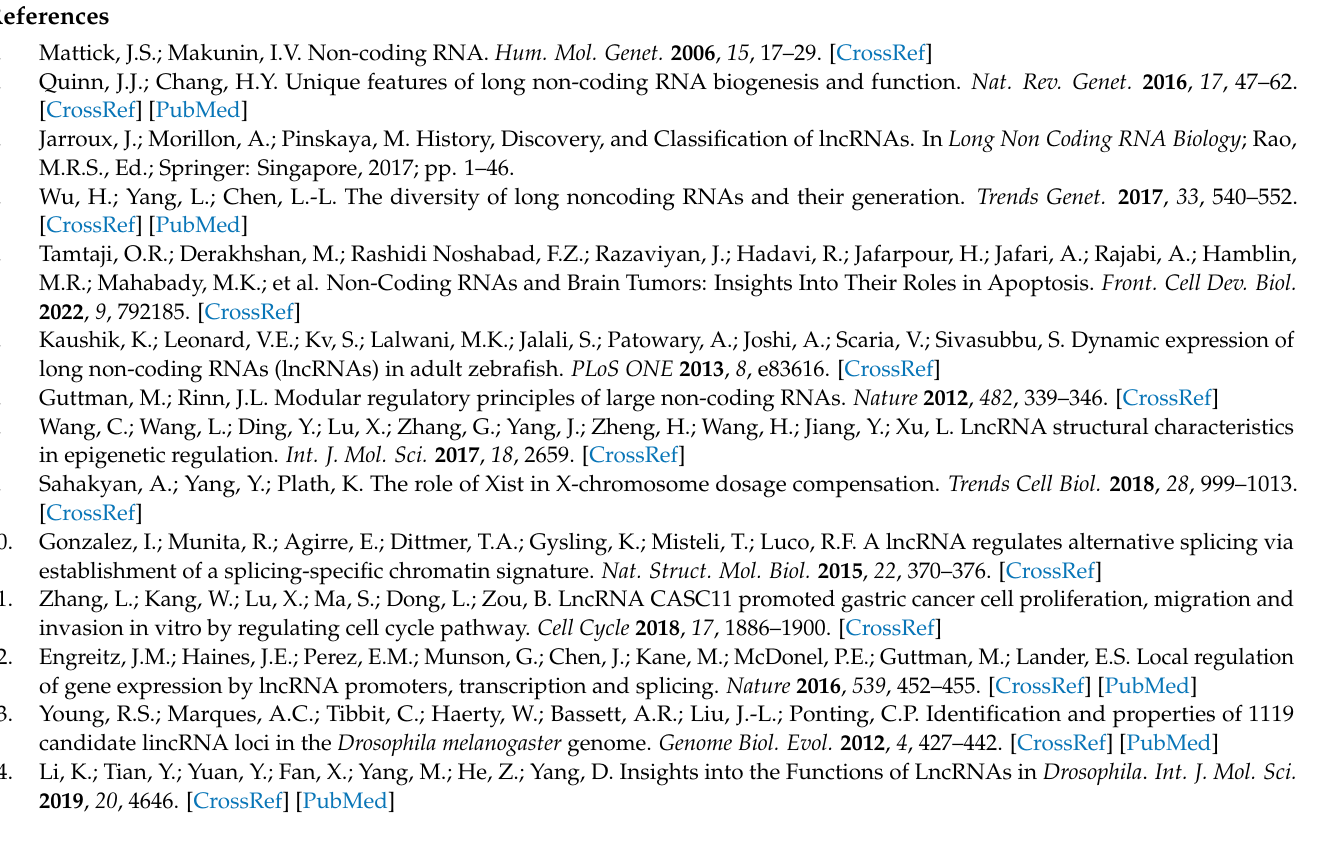
Table S14: Prediction of lncRNAs as the precursor of miRNAs in Metarhizium anisopliae